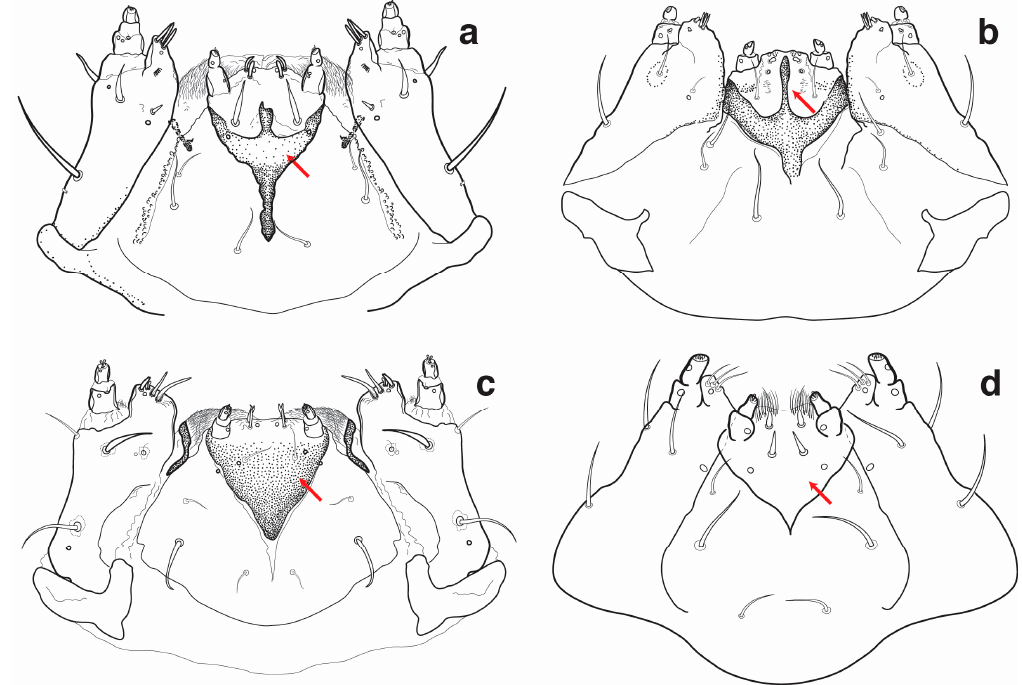
Figure 55. Labium, larva: ( a ) Phacecorynes ; ( b ) Sipalnus ; ( c ) Cosmopolites ; and ( d ) Nephius .